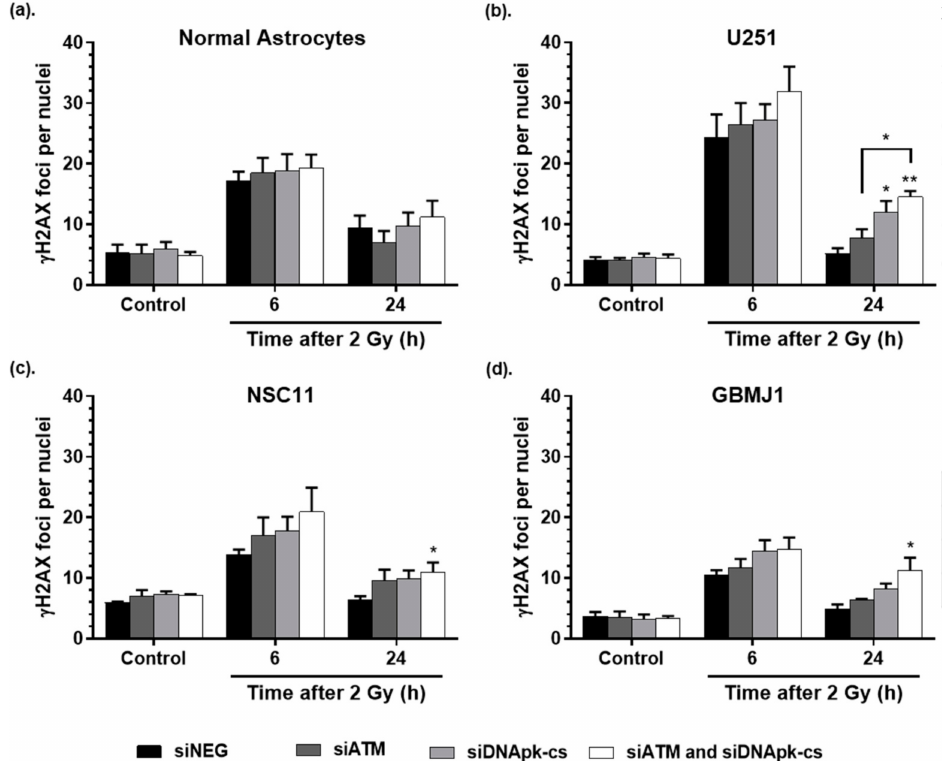
Figure 4. Influence of ECO nanoparticle delivery of siRNA on gH2AX foci formation and repair in ( a ) normal astrocytes, ( b ) glioma, and ( c , d ) glioma stem cell lines. Cells receiving no radiation were used as a control. Foci were counted in 50 nuclei per treatment, per experiment. Values are represented as the mean ± SEM of 3 independent experiments. (Significance in comparison to siNEG at 24 h unless indicated otherwise according to ANOVA testing with Tukey post-analysis (* p < 0.05, ** p <